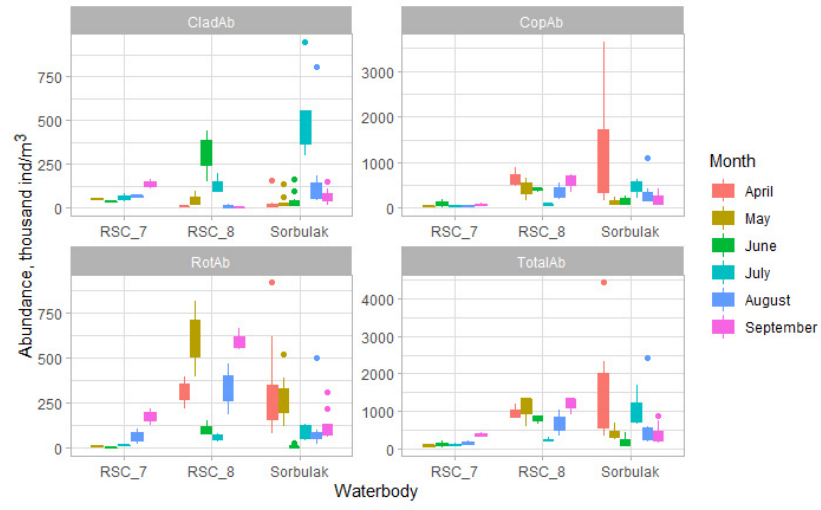
Figure 7. Dynamics of the zooplankton abundance in wastewater reservoirs of the Right-Bank Sorbulak Canal system during six warm months of 2021.